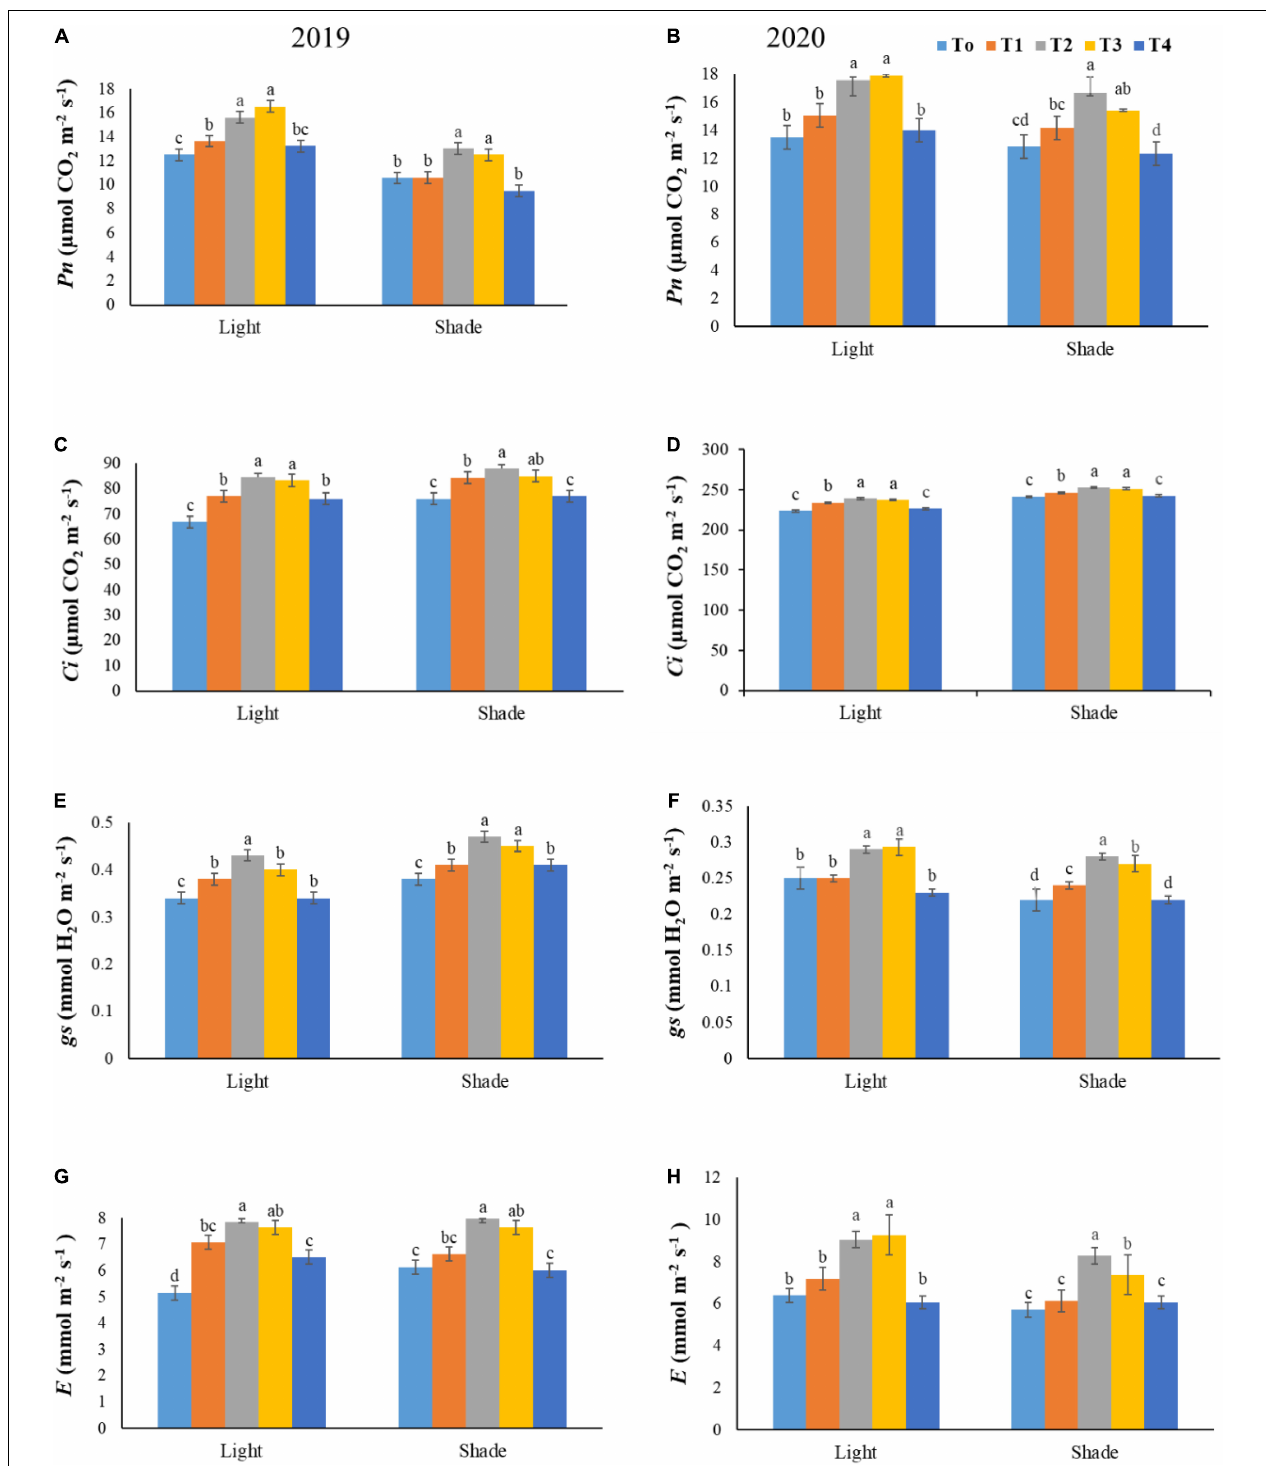
FIGURE 7 | Effect of various ratios of NH 4 + /NO 3 − on the net photosynthetic rate ( Pn ) (A,B) , intracellular CO 2 ( Ci ) (C,D) , stomatal conductance ( gs ) (E,F) , and transpiration rate ( E ) (G,H) under both light and shade conditions. Different treatment levels T0, T1, T2, T3, and T4 characterize the ratios of NH 4 + /NO 3 − 0/0, 0/100, 25/75, 50/50, and 75/25, respectively. All of the results are the mean of three replications. The bars represent the ± SD (standard deviation). A significant difference ( ∗ p < 0.05) between treatments is shown by different lowercase letters above bars.